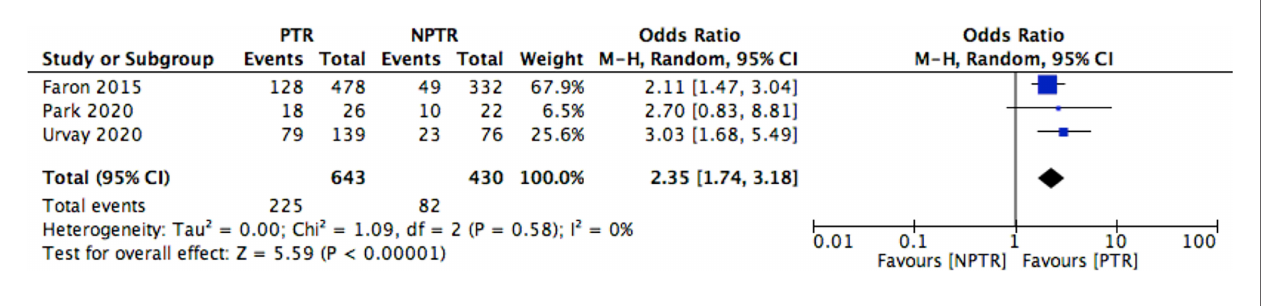
FIGURE 4 | 2-year OS rate Forest.